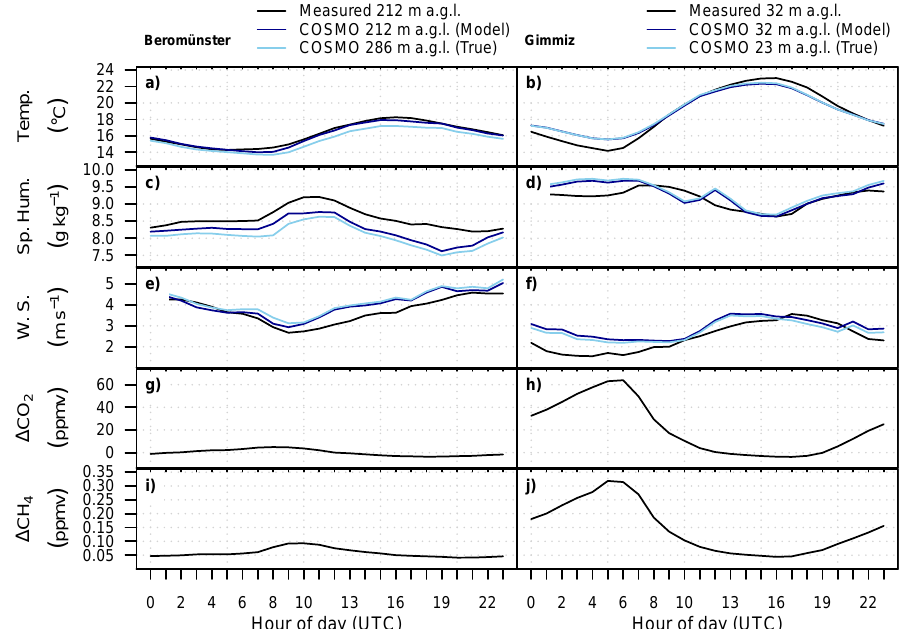
Figure 5. Mean summer (June–August 2013) diurnal cycle of measured and simulated local meteorology at the sites Beromünster and Gimmiz: (a and b) temperature, (c and d) specific humidity (Sp. Hum.), and (e and f) wind speed (W. S.). Also shown are mean diurnal cycles of measured (g and h) regional CO 2 signals ( (cid:49) CO 2 ), and (i and j) regional CH 4 signals ( (cid:49) CH 4 ). The measurement and simulation heights above ground are listed in the figure legends. Simulated meteorology is shown for two different heights, the height of the measurement a.m.g.l. (Model, dark blue), and the simulation height a.m.g.l., which corresponds to the “true” measurement altitude a.s.l. (True, light blue). The time zone in Switzerland is central European time (CET or UTC + 1).